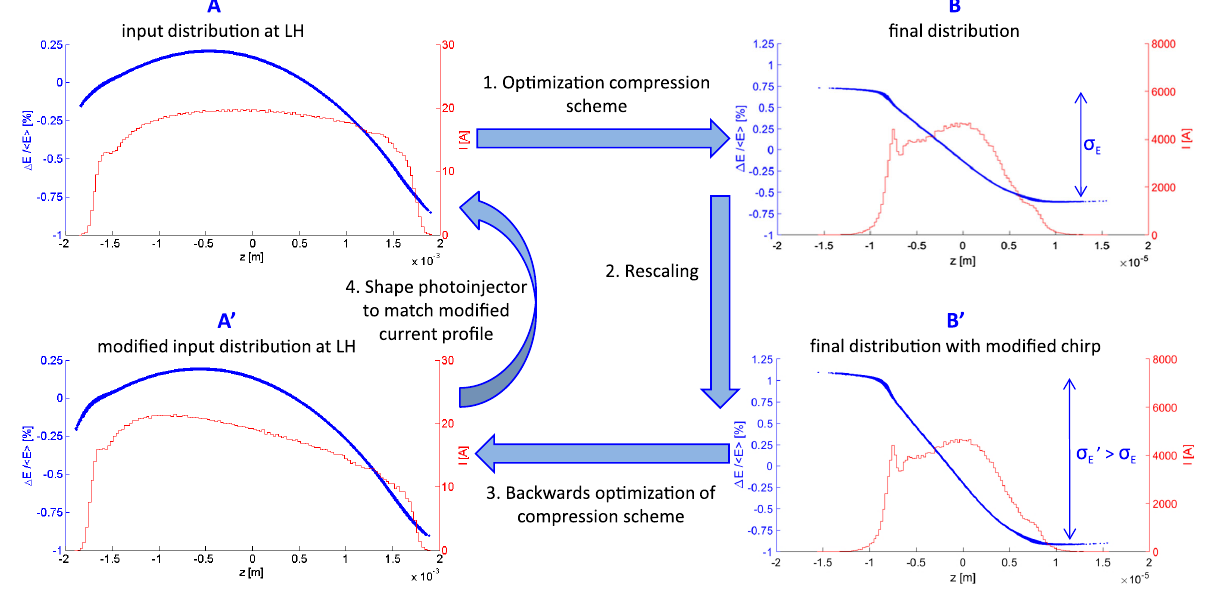
FIG. 3. Scheme of the procedure to generate electron beams with a large energy chirp at the entrance of the undulators, by optimizing the compression scheme of the linac and the electron distribution at the